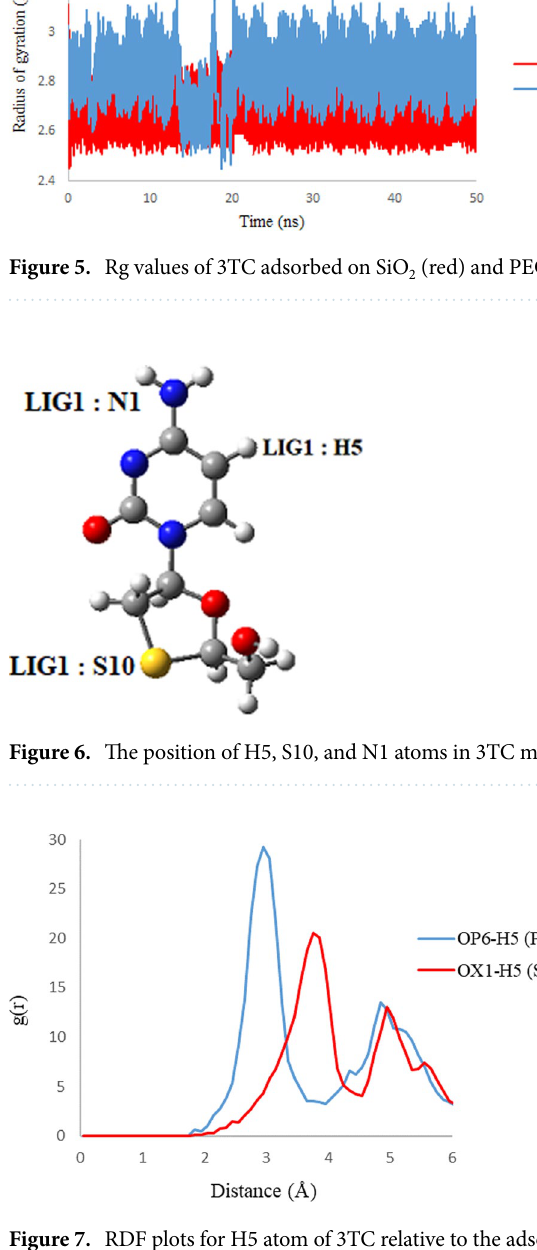
Figure 7. RDF plots for H5 atom of 3TC relative to the adsorption sites of SiO 2 (red) and PEG